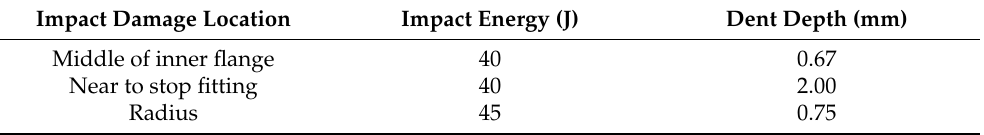
Figure 13. Overview of impact damage in the door panel. Table 3. Overview of impact damage in the Omega profile. Table 3. Overview of impact damage in the Omega